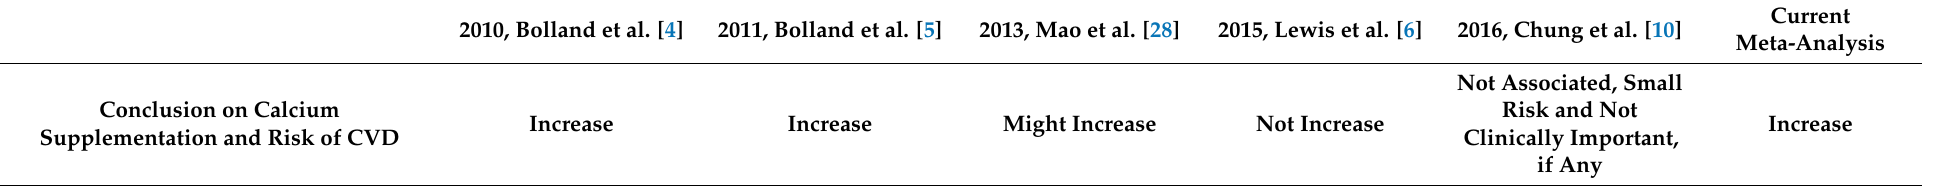
Table 2. Differences in the main findings and study characteristics among previous systematic reviews and meta-analyses and the current systematic review and meta-analysis of clinical trials on calcium supplementation and the risk of cardiovascular